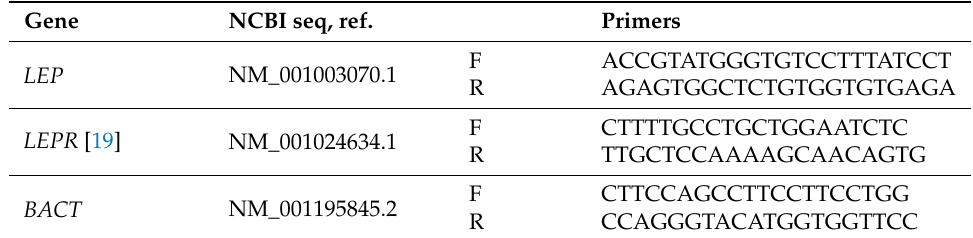
Table 2. Primers for leptin ( LEP ), leptin receptor ( LEPR ) and beta-actin Ct ( BACT ) housekeeping gene used for Real-Time PCR